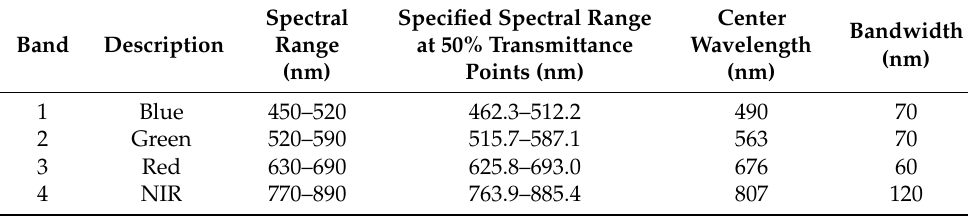
Figure 1. Normalized spectral response function of the ZY3 MUX. Table 2. The spectral responses properties of ZY3-02